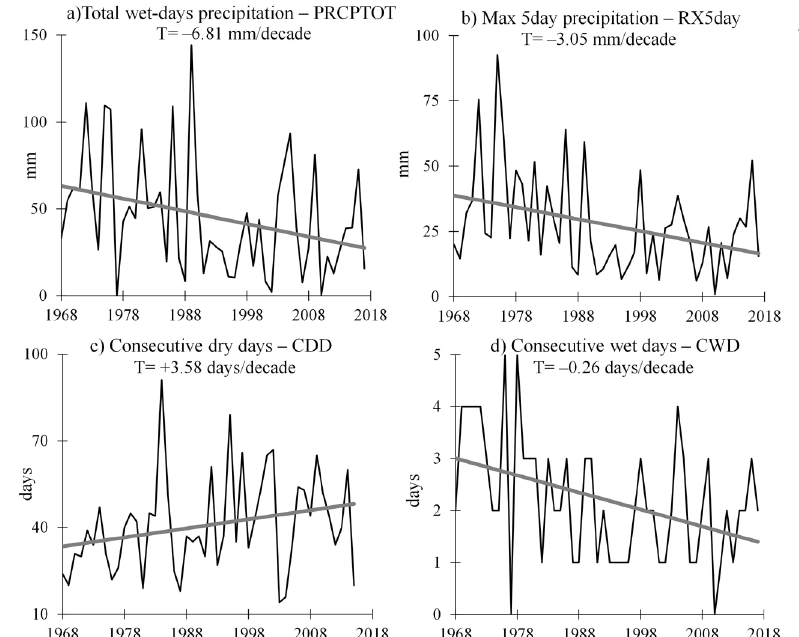
Figure 7. Temporal distribution of the extreme precipitation indices in the 1968–2017 period for winter (JJA= June, July and August). Index with gray line indicates significant linear trend (Table III), at least at the 95% confidence level. T indicates magnitude of